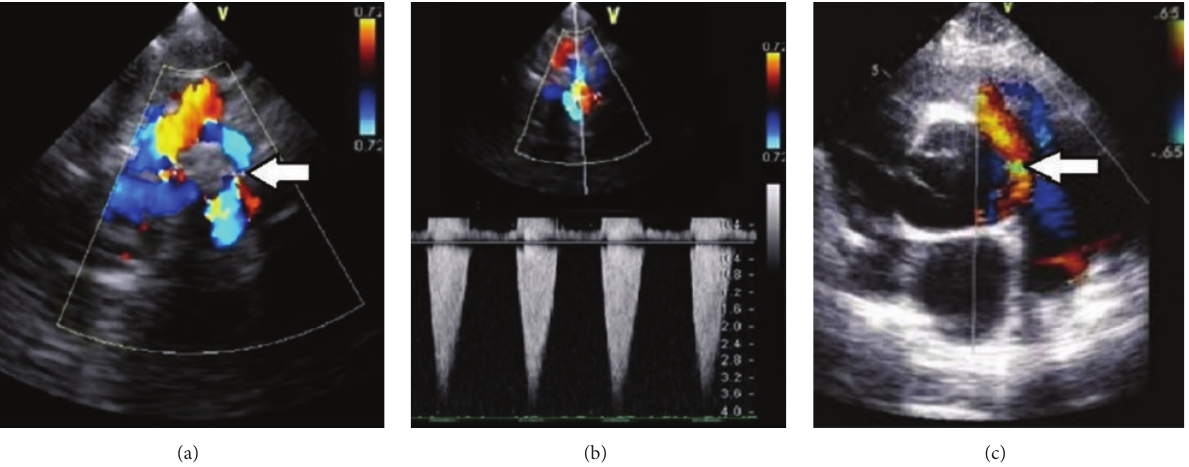
Figure 1: (a) Color flow Doppler imaging echocardiogram on the suprasternal longitudinal view showing coarcted segment of aorta with turbulence (arrow) in the descending aorta. (b) Continuous wave Doppler flow echocardiography demonstrating the coarctation gradient with a peak flow velocity in the descending aorta of 3.8 m/s which corresponds to a maximal gradient of 58 mmHg. (c) The two-dimensional echocardiogram, with color flow Doppler, recorded from the parasternal short-axis view, shows blood flow through a patent ductus arteriosus (arrow).